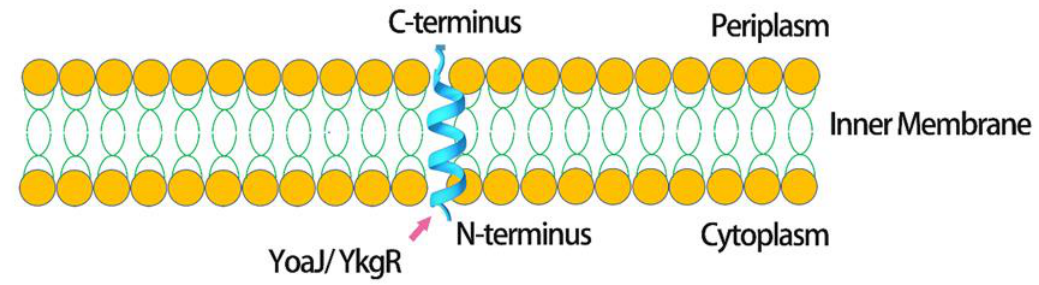
Figure 3. Location of the fusion tag (YoaJ / YkgR, small peptide, or protein) and recombinant peptide in E. coli , where OM is the outer membrane and IM is the inner membrane.